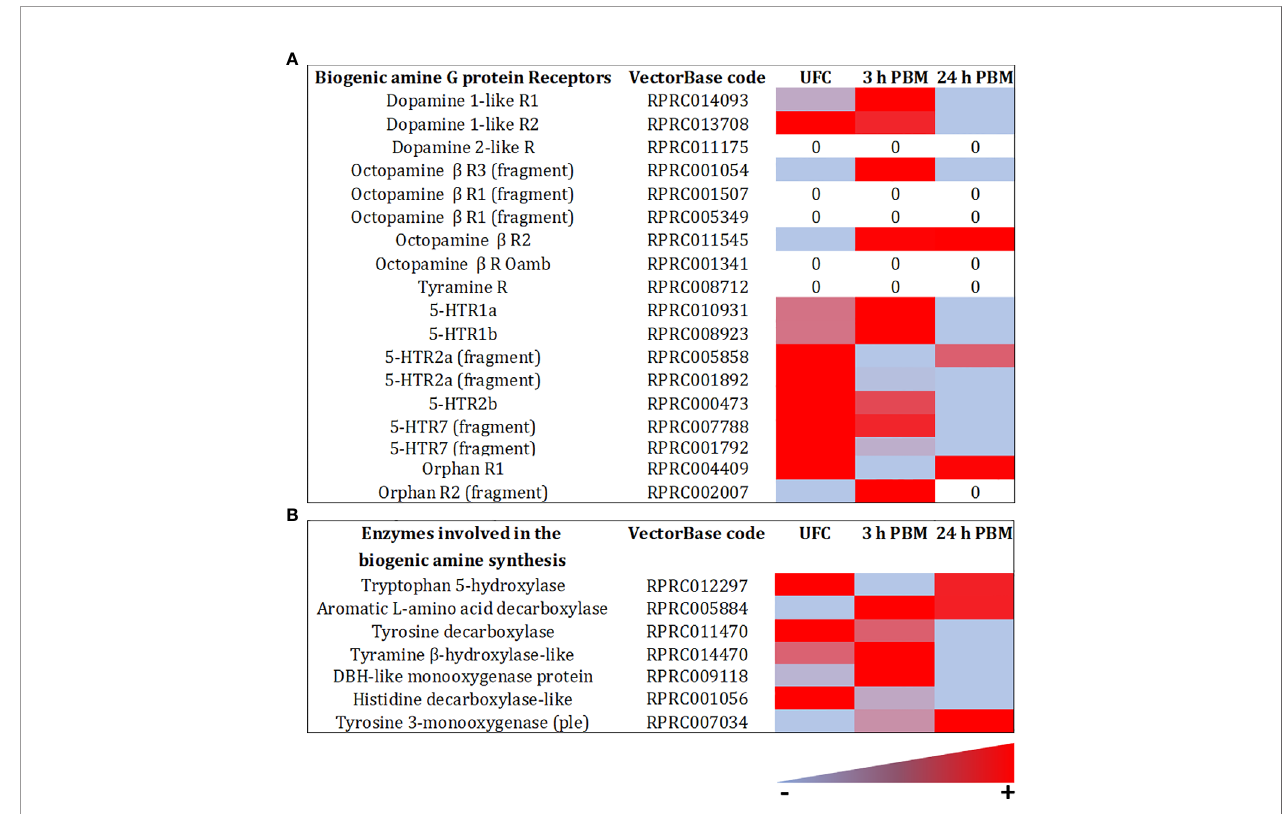
FIGURE 5 | Heat map comparing the mRNA expression levels of (A) biogenic amine G protein- coupled receptors family A, and (B) the enzymes involved in biogenic amine synthesis in Malpighian tubules from insects unfed (UFC), 3 h and 24 h post blood meal (PBM). The input data is the readcount value from gene expression level analysis after normalization and is presented using a color scale, in which light blue/red represent lowest/highest expression. DESeq was used to perform the analysis. Details of transcript expression are shown in Supplementary Worksheets 1 , 2